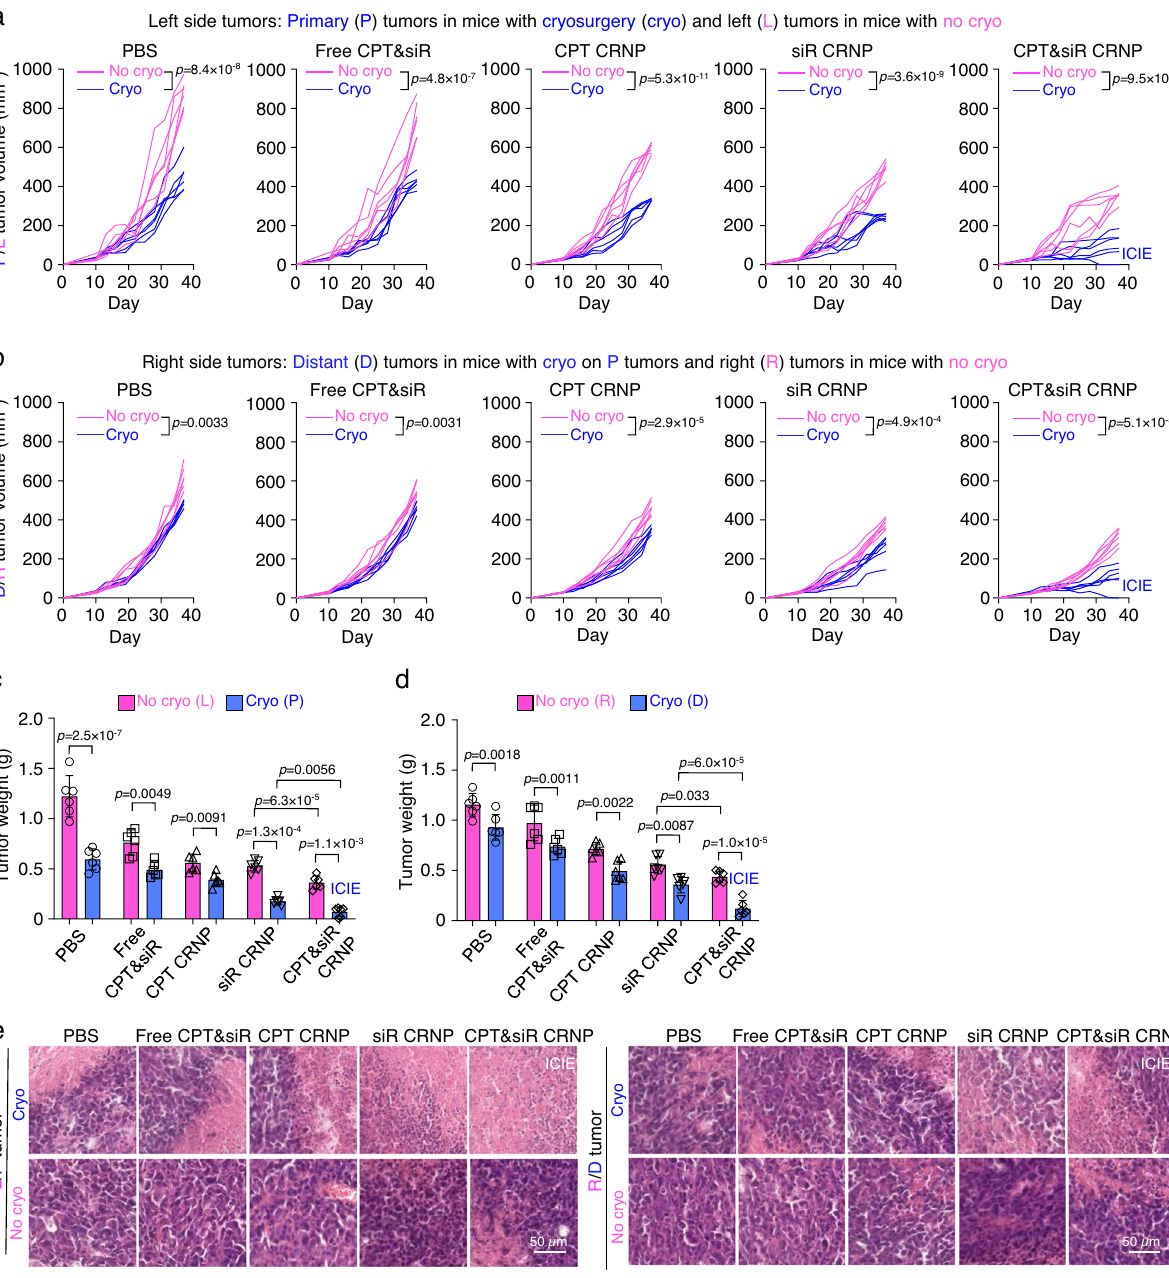
versusD, d )tumors( n =6mice)obtainedaftersacri fi cingthemiceattheendofthe study,showingeffectivetumordestructionbytheICIEtreatment. e Representative hematoxylinandeosin(H&E)stainingimagesofleft-side(LversusP)andright-side (R versus D) tumors, showing extensive necrosis in both the primary and distant tumors from mice with the ICIE treatment. The experiments were repeated three timesindependently( n =3mice)withsimilarresults.Statisticalanalysesweredone using two-way ANOVA with Sidak ’ s post-test and correction for multiple compar- isons.Dataarepresentedasmean±SD( c , d ).SourcedataareprovidedasaSource Data fi